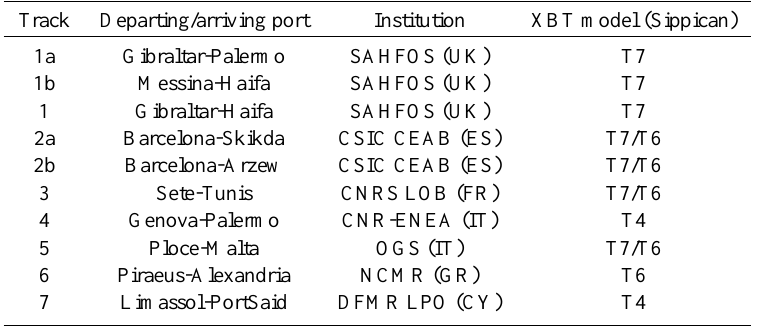
Table 1. Ship-of-opportunity tracks, departing/arriving port, institutions involved and XBT model in the MFSPP Track